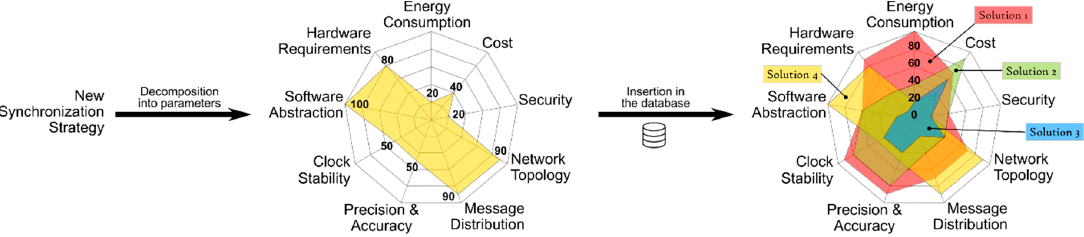
Figure 2. Graphical representation of the insertion of a new synchronization strategy into the database with all the possible solutions. This example shows the insertion of the fourth solution.